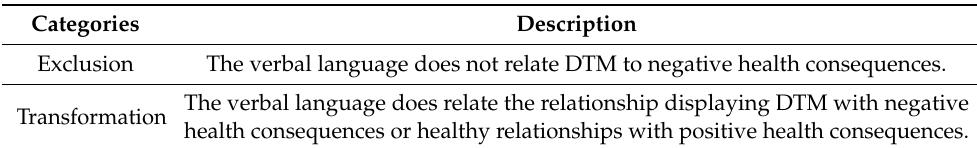
Table 3. Categories of Communicative Interviews.